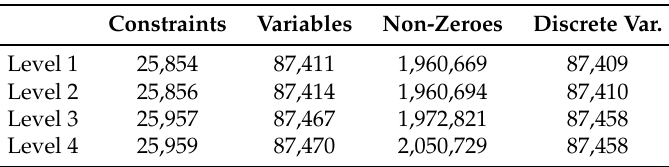
Table 5. Size of the resulting models level by